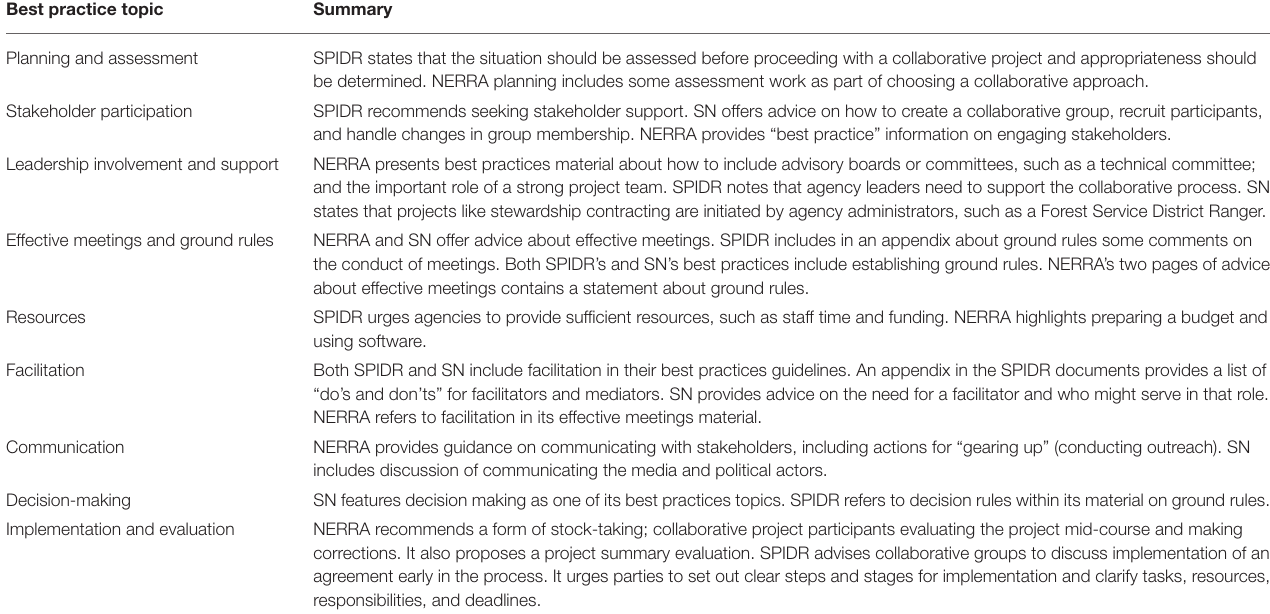
TABLE 1 | Recommended best